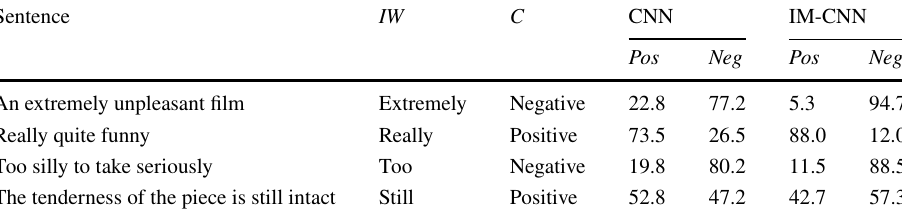
Table 7 Examples about the effect of intensive words on MR